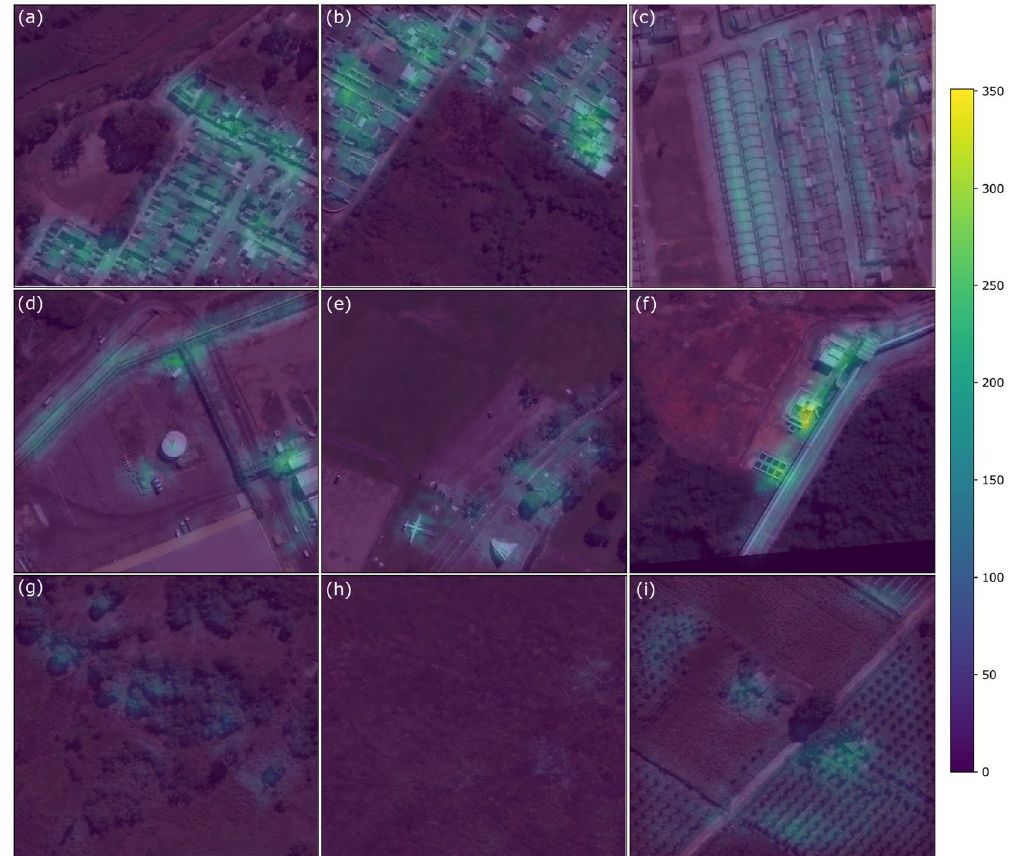
Figure 5. Samples from the experiment results with symmetry density overlayed on top of the original images on the same color scale (0 to 350), ( a ) image 1361 shows city structures with high symmetry density in the bottom-right and vegetation with low symmetry density in the upper-left portion, ( b ) image 1284 also showing symmetric urban areas in the upper-left and upper-right side, ( c ) image 5864 with rows of buildings with symmetric centers, ( d ) image 581 industrial center with circularly symmetric facility, ( e ) image 1014 oddly shaped building and potentially an aircraft in the lower left, ( f ) image 12 an industrial facility with highly symmetric tanks, ( g ) image 1363 show some symmetry density in the distribution of trees, ( h ) image 1395 show no symmetry density in an open field, and ( i ) image 1308 showing symmetric vegetation in fields.